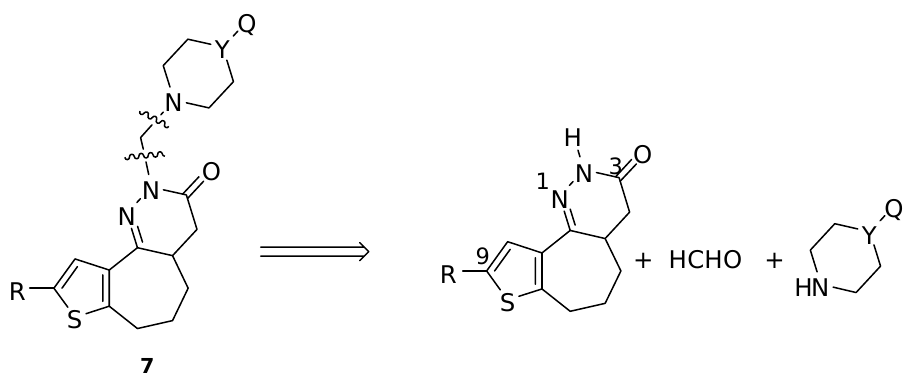
Figure 2. The retrosynthetic analysis of the target compounds 7